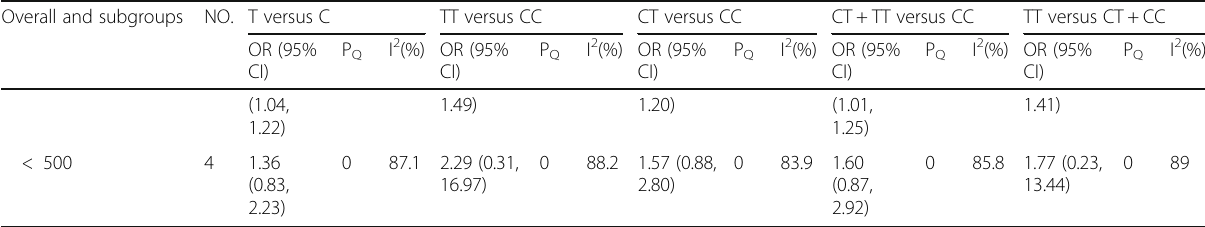
Table 4 Overall and subgroups meta-analysis of H19 rs217727 (C > T) polymorphism and cancer risk (Continued) Overall and subgroups NO. T versus C